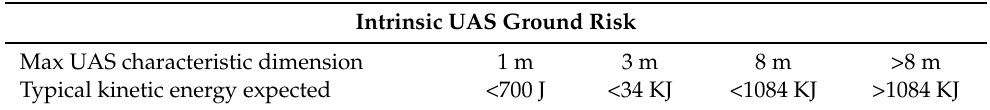
Table 2. Determination of the intrinsic ground risk classes (GRC)